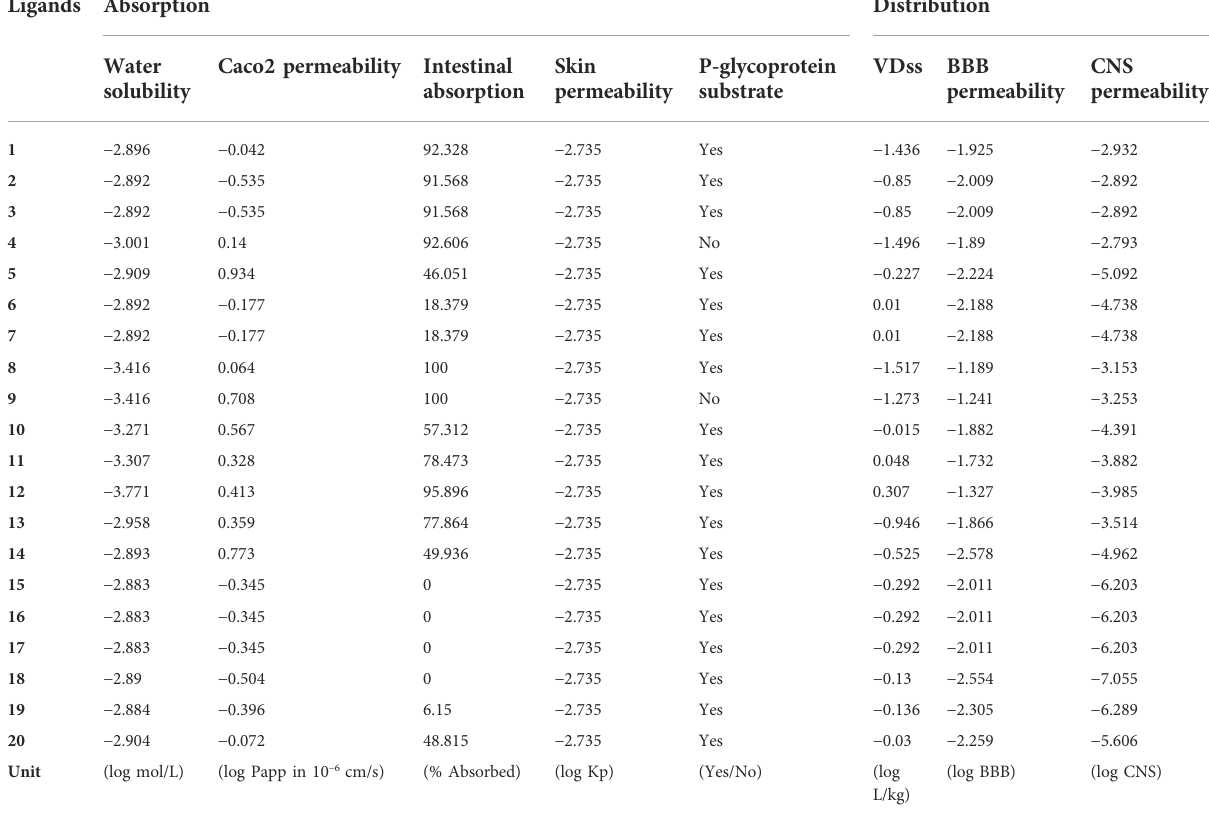
TABLE 7 Absorption and distribution prediction of the top 20 compounds screened by normalized